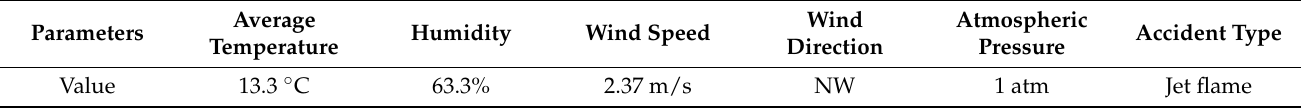
Table 2. Detailed initial conditions used in